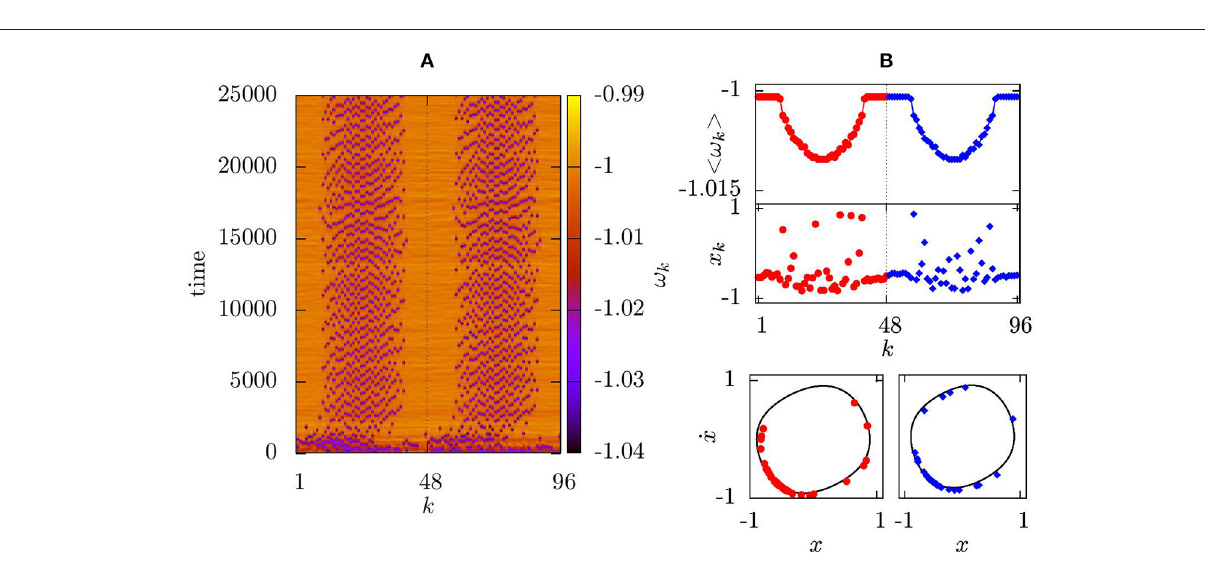
FIGURE 6 | Mean phase velocities for a two-layer system of N = 48 oscillators in the layers and non-identical coupling ranges: R 1 = 16, R 2 = 18, other parameters: ε = 0.2, a (1) = a (2) = 0.02, a inter = 0.009, b inter = 0.0023, K a = 2, K s = 0.5, b (2) − = b (2) + = 0.0027. Oscillators k = 1...48 represent the first layer, k = 49...96 the second layer; (A) space-time plot; (B) mean phase velocity profile averaged over 25,000 time units for the first layer (red dots) and the second layer (blue diamonds) (top panel); snapshot of variables x k (middle panel) and snapshot in the ( x k ; ˙ x k ) phase space at t = 25,000 (bottom